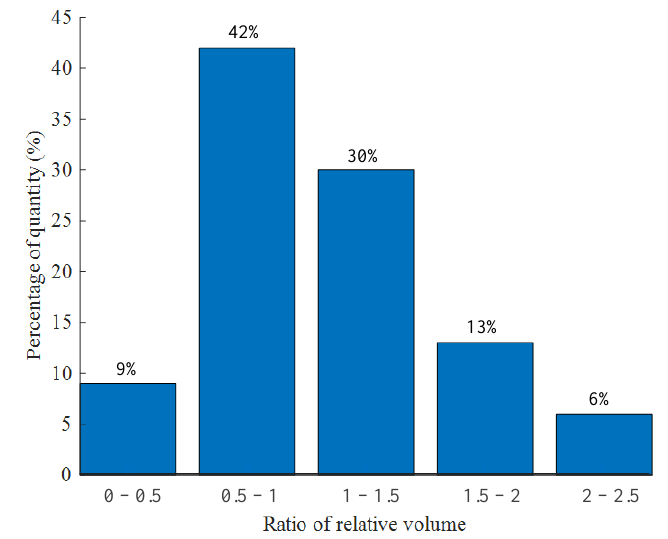
Figure 4. Distribution of ratio of relative volume for fertilizer particles.